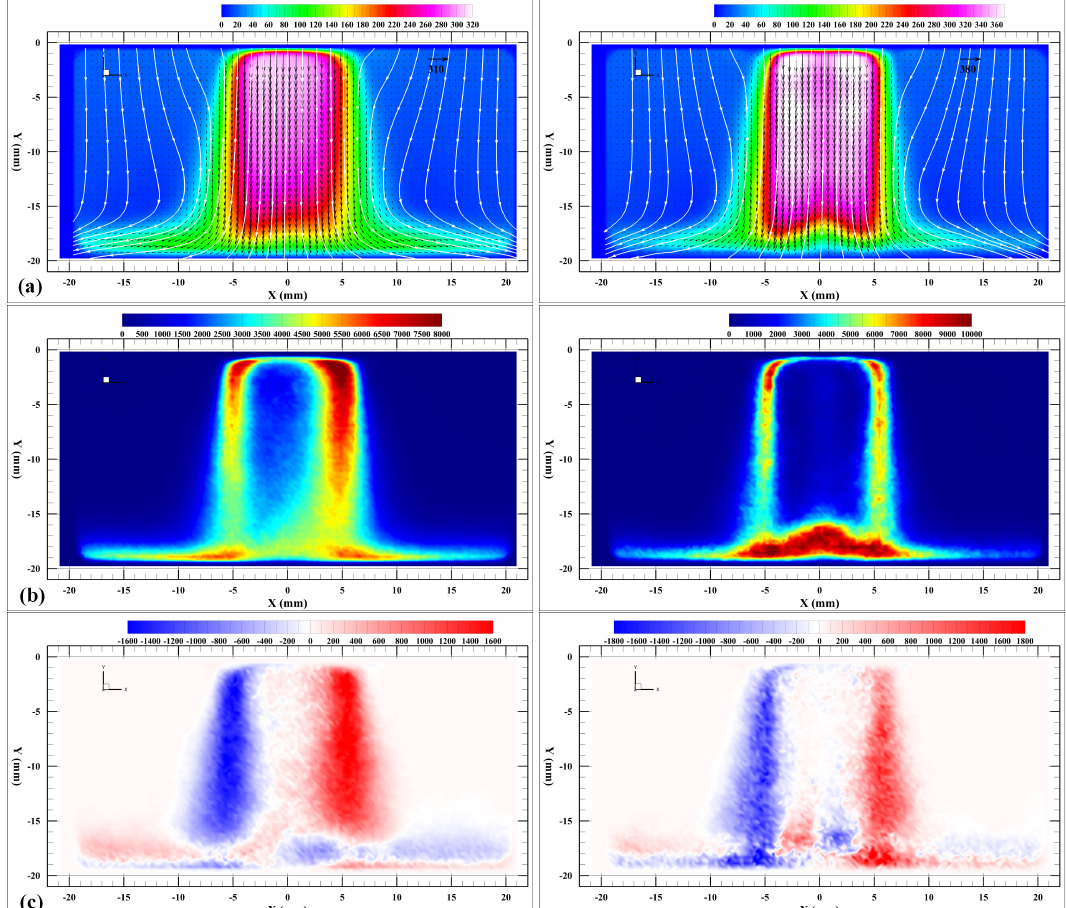
Figure 5. PIV results obtained from experimental measurements of under-expanded impinging jets with the nozzle-to-plate e = 20 mm ( e / D j = 1.64) and at NPR 2 = 2.2 (left) and NPR 4 = 2.77 (right). ( a ) Mean in-plane velocity fields, color contour of velocity magnitude (m/s) and velocity streamlines, color contours of ( b ) turbulent kinetic energy k (m 2 /s 2 ), and ( c ) Reynolds stress (cid:104) u (cid:48) v (cid:48) (cid:105) (m 2 /s 2 ). Vectors were de-sampled for better